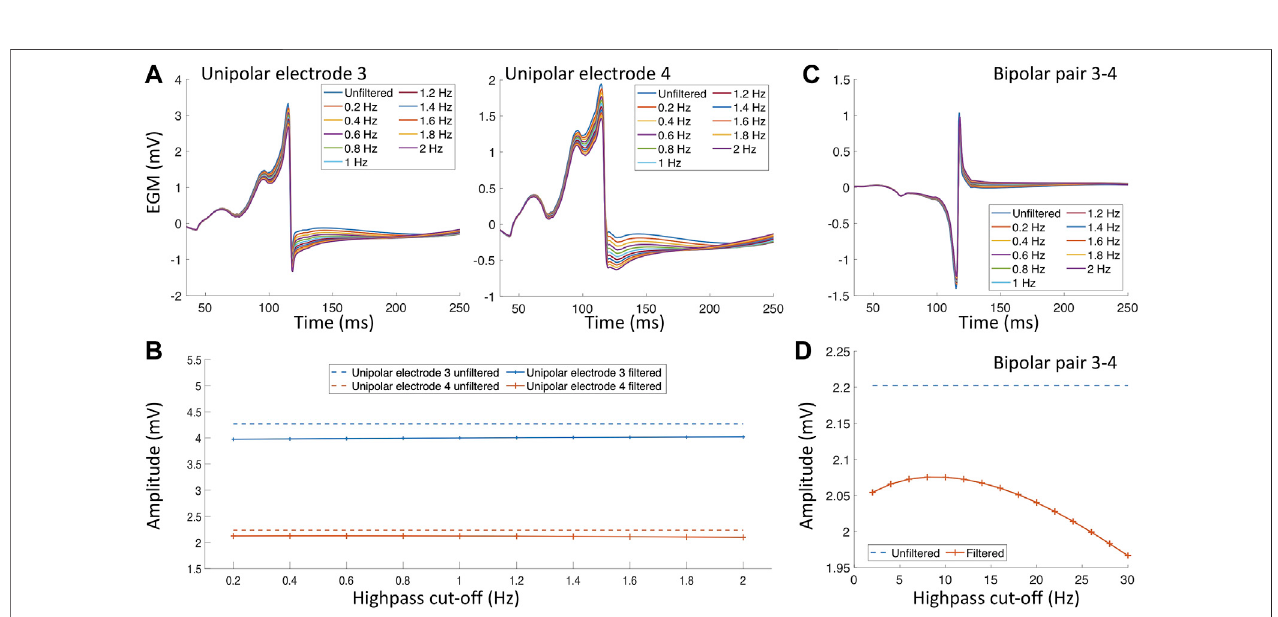
FIGURE 5 | Filter effect on electrograms measured in the proximity of a fi brotic area. (A) Unipolar electrograms with different highpass fi lter values. (B) Effect of differenthighpasscut-offvaluesontheunipolarelectrogramamplitude. (C) Bipolarelectrogramwithdifferenthighpasscut-offvalues. (D) Effectofdifferenthighpasscut- off values on the bipolar electrogram